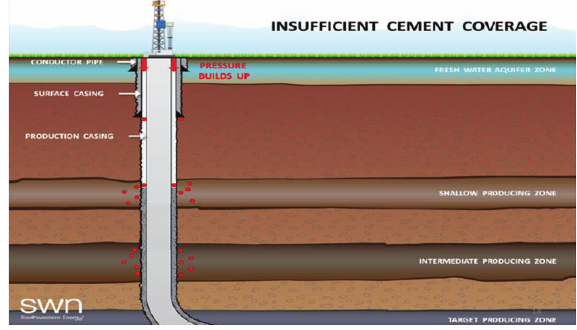
Figure 2: Illustration of insufficient cement coverage